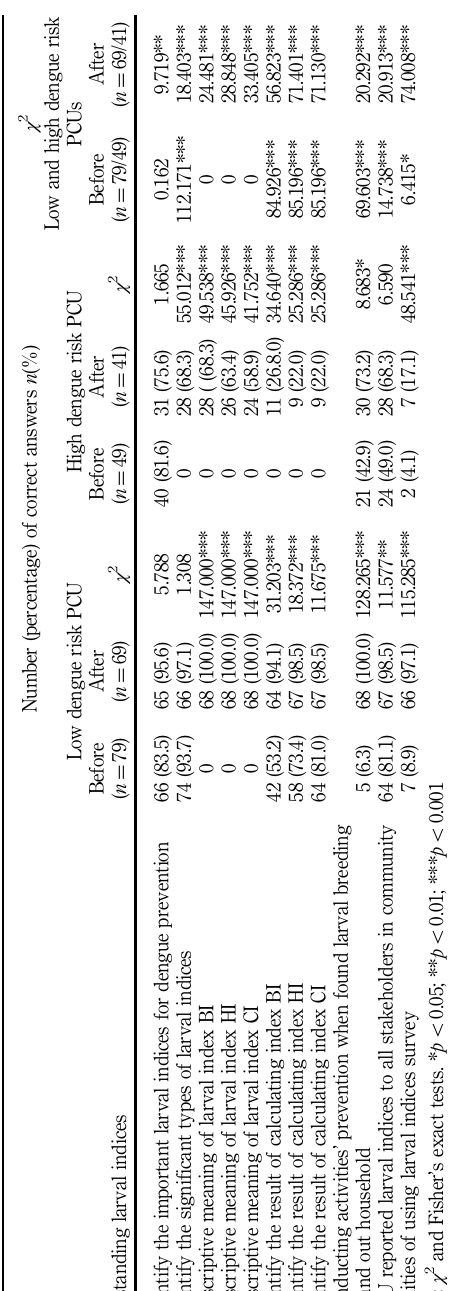
Table IV. Understanding larval indices of low and high dengue risk